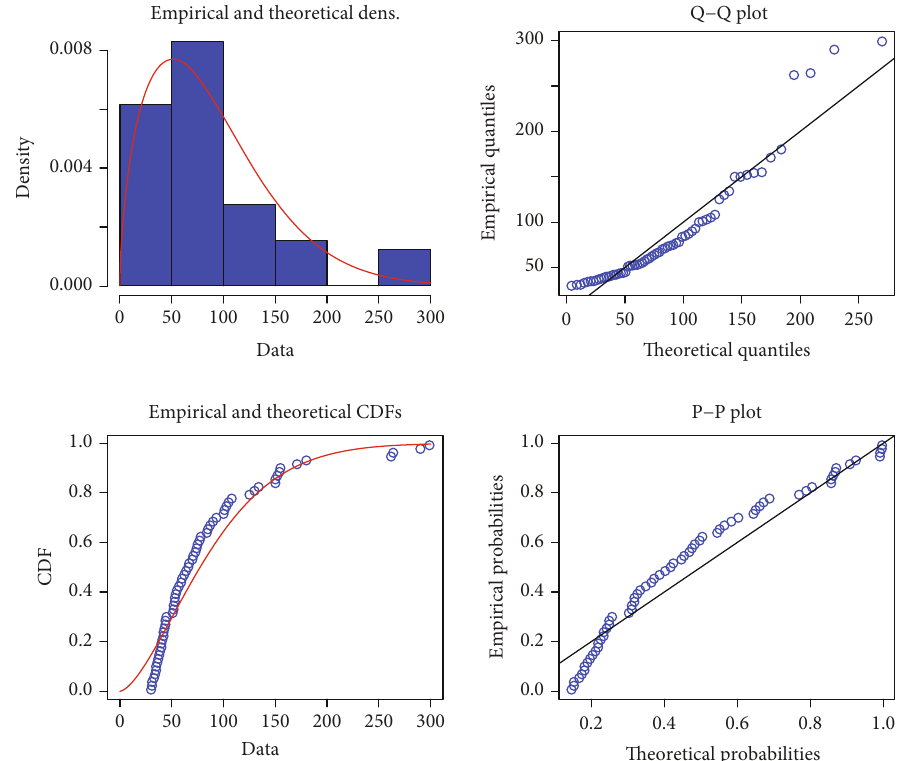
Figure 14: The estimated CDF, fi tted PDF, P-P plot, and Q-Q plot of the XGAIW distribution for complete breast cancer